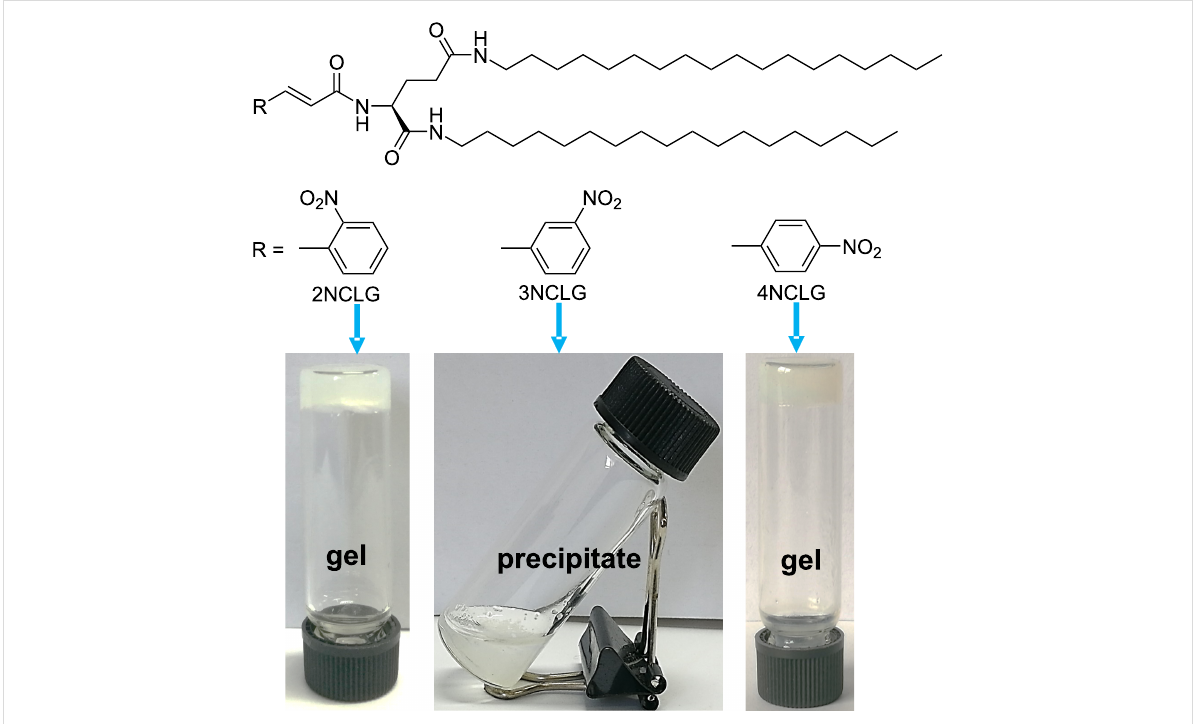
Figure 1: Molecular structure of three nitrocinnamic amide-containing ʟ -glutamic amphiphiles and photographs of their self-assembled molecules in ethanol.